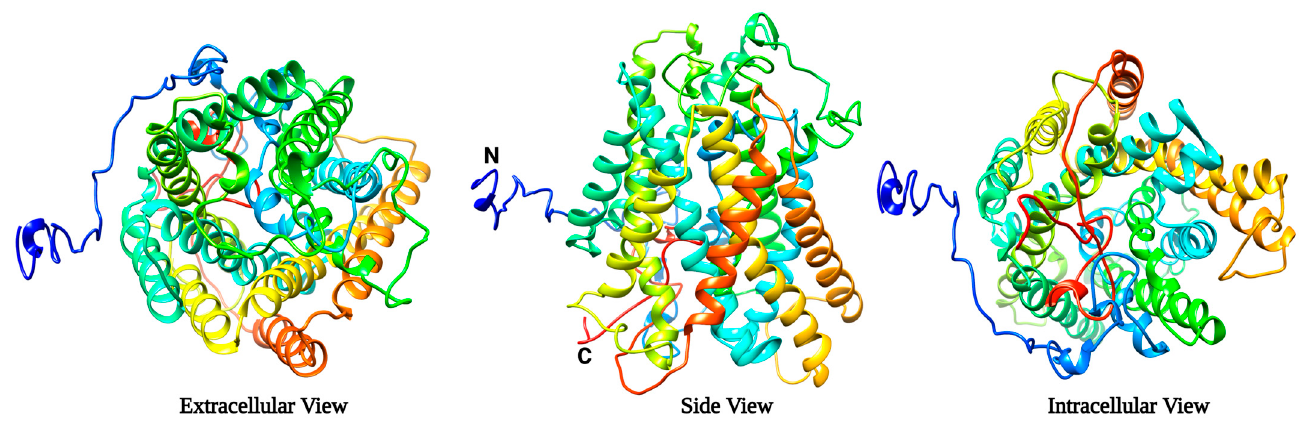
Figure 2. I-TASSER predicted model of Agp2 from di ff erent views. Extracellular is the top view from the outside of the lipid bilayer. The side view is from the front looking across the lipid bilayer, N and C denote N- and C-termini, respectively. The intracellular view is from the inside of the cell.